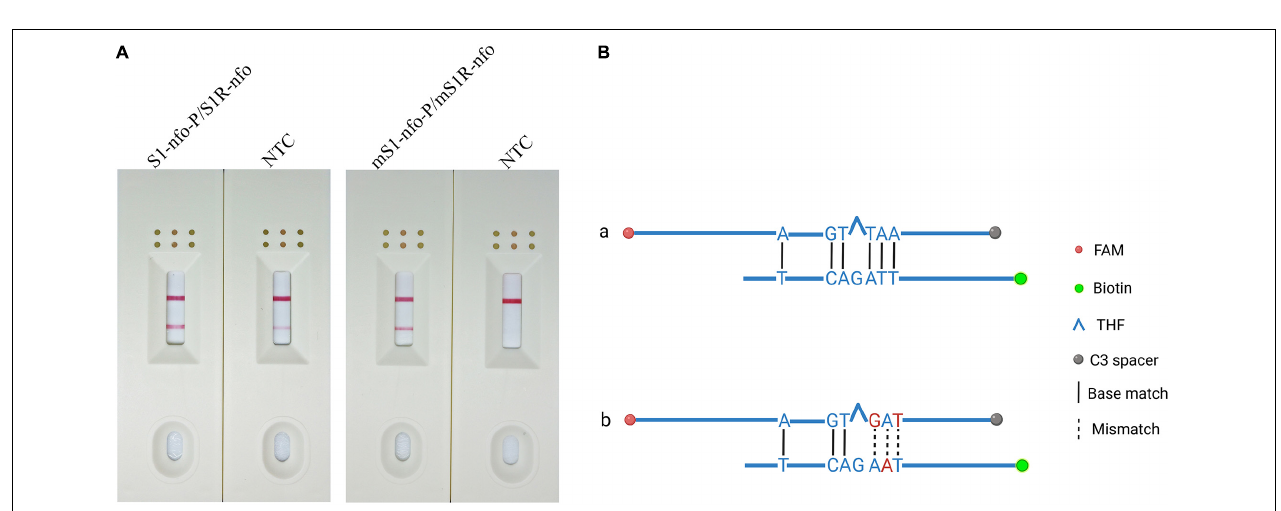
FIGURE 2 | Screening of primer pairs by Basic-RPA. The image shows amplification bands targeting the syg-2 gene. The primer name is shown above each lane. The following Bx, Bm, and NTC lanes are B. xylophilus , B. mucronatus genomic DNA, and no template controls for corresponding primer pairs, respectively. Band sizes for DNA ladders are shown on the left.